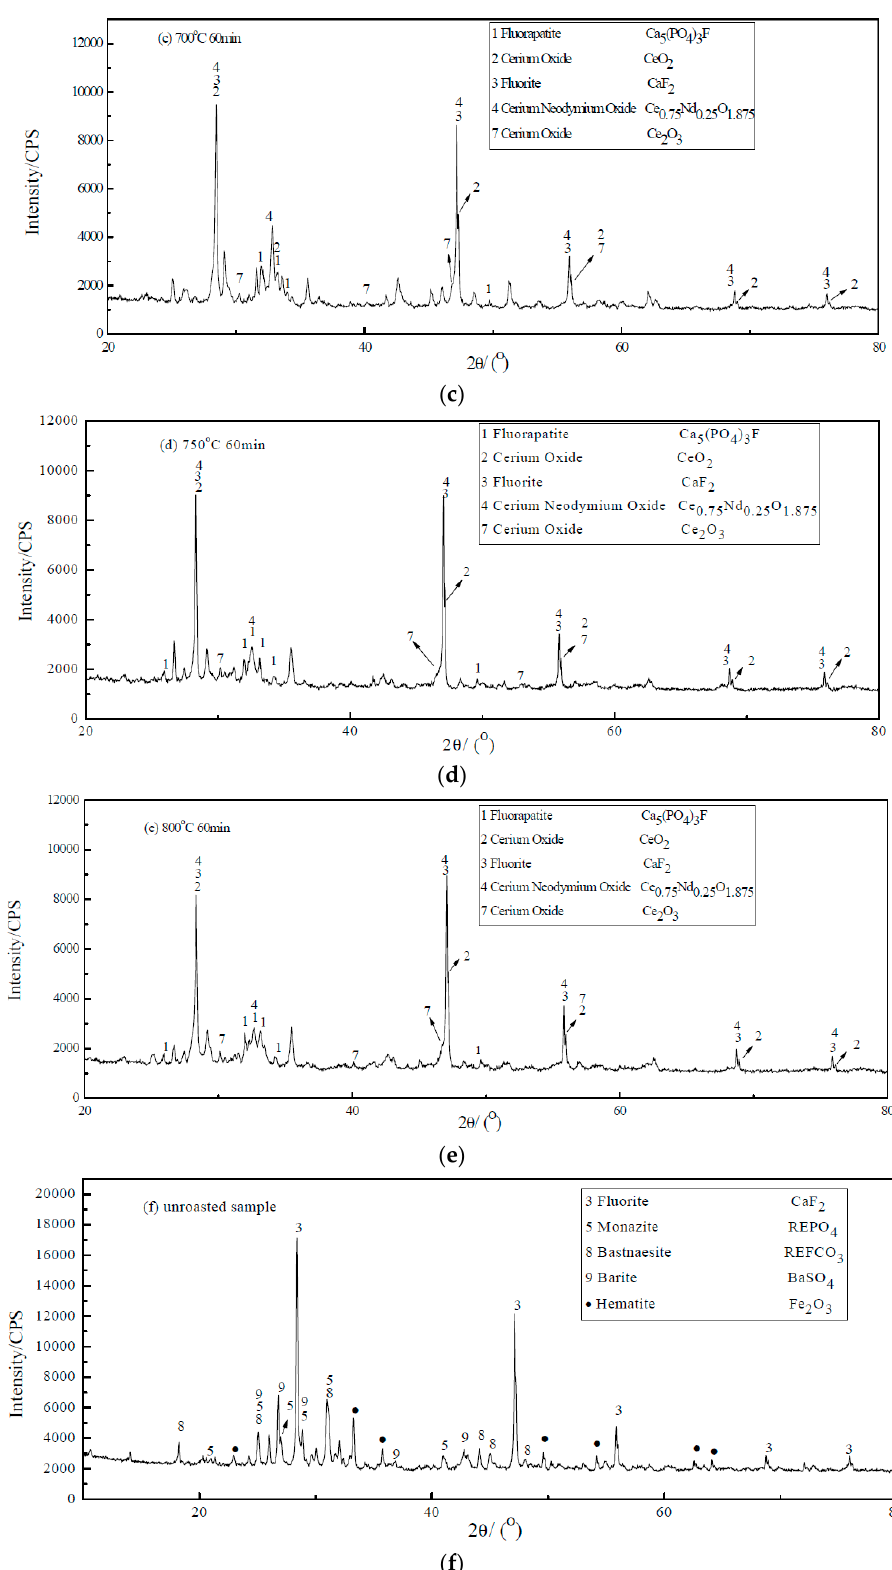
Figure 1. XRD pattern of REE under different conditions. ( a ) at 600 °C for 60 min; ( b ) at 650 °C for 60 min; ( c ) at 700 °C for 60 min; ( d ) at 750 °C for 60 min; ( e ) at 800 °C for 60 min; ( f ) unroasted sample.